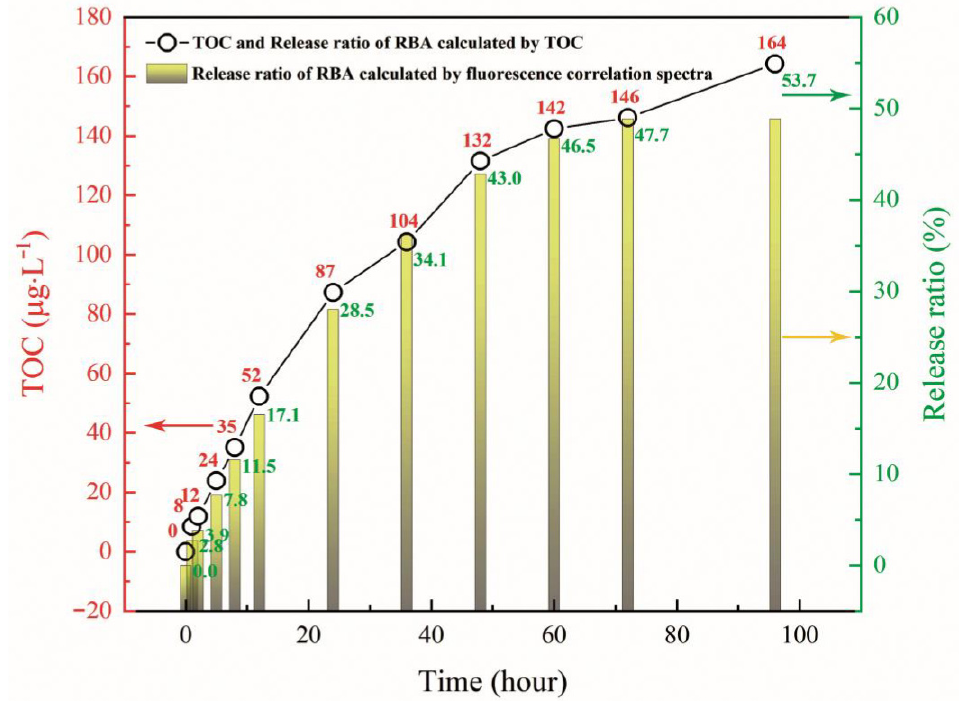
Figure 11. TOC detection results of RBA/ZEO dispersed in 3.5% NaCl solution for different times and RBA release ratio calculated from TOC (dot and line) and fluorescence correlation spectra (histogram).